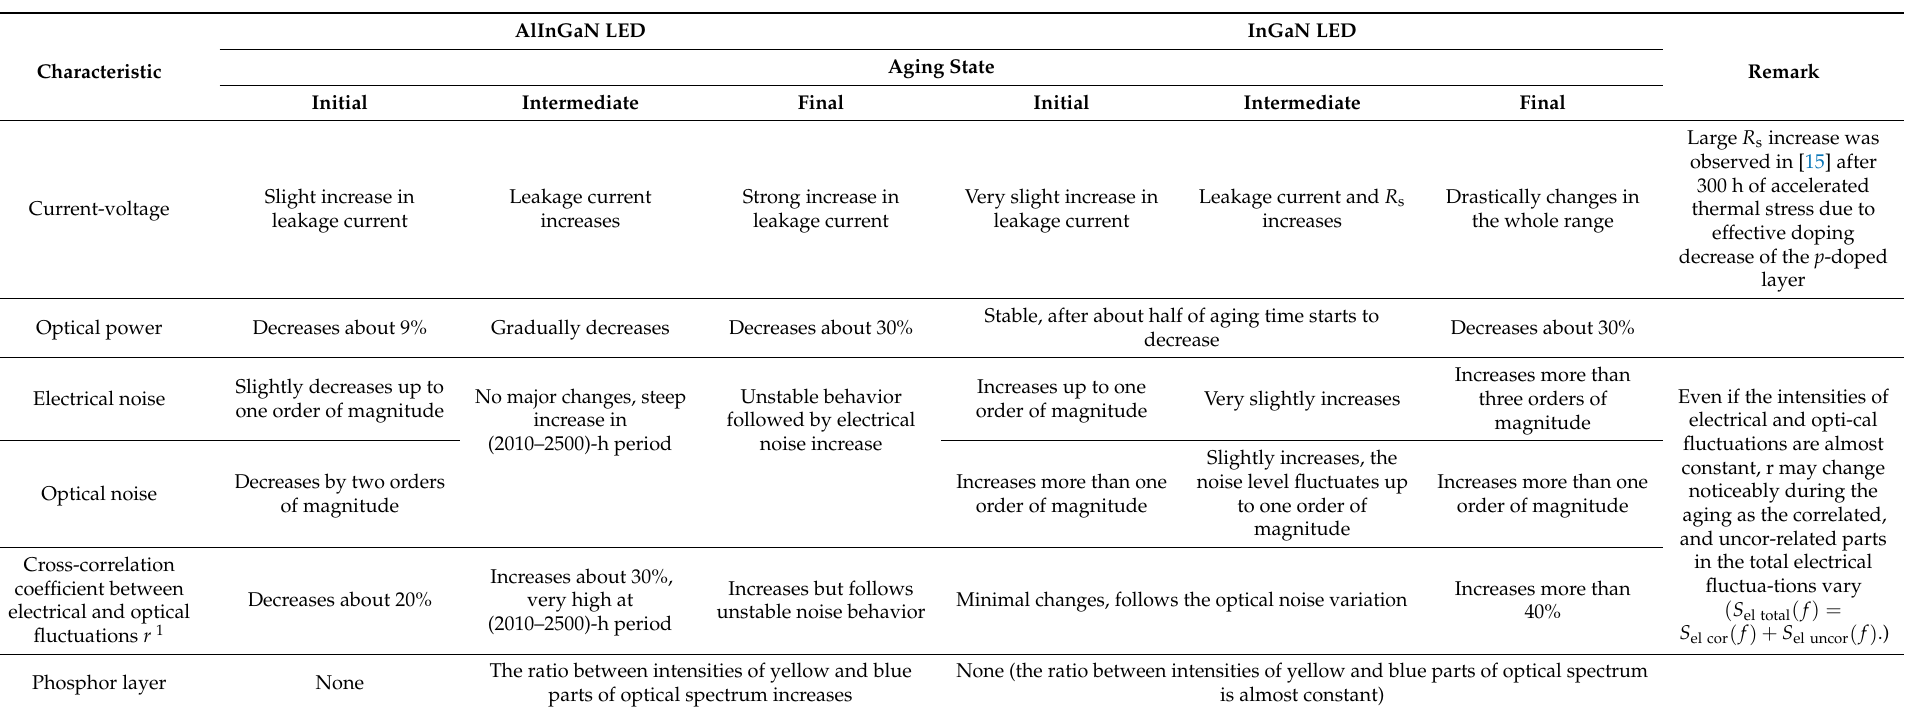
Table 3. Comparison of changes of the electrical and optical noise characteristics of the high-power white AlInGaN and InGaN LEDs during the long-term aging at